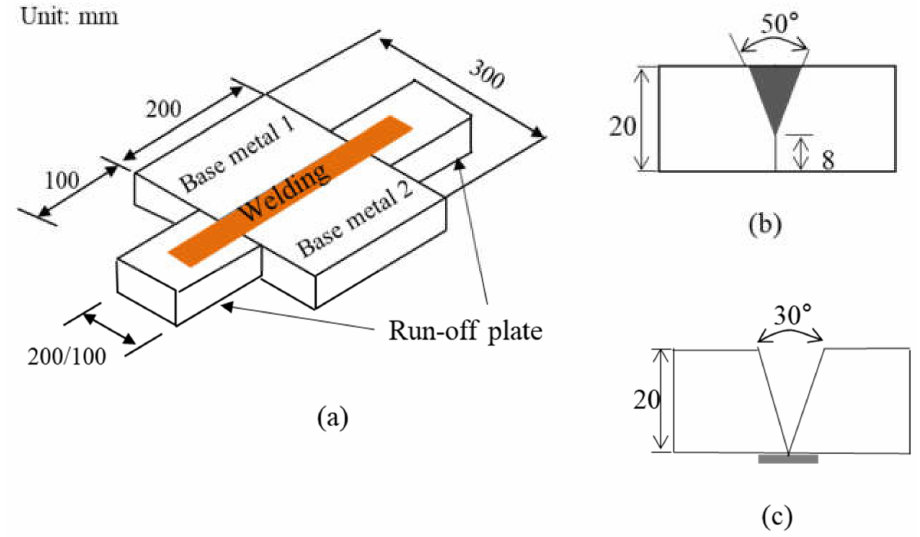
Figure 1. Dimension and groove shape: ( a ) dimension and configuration; ( b ) submerged arc welding (SAW) (B1, B2, B3, and B4); and ( c ) flux-core arc welding (FCAW)